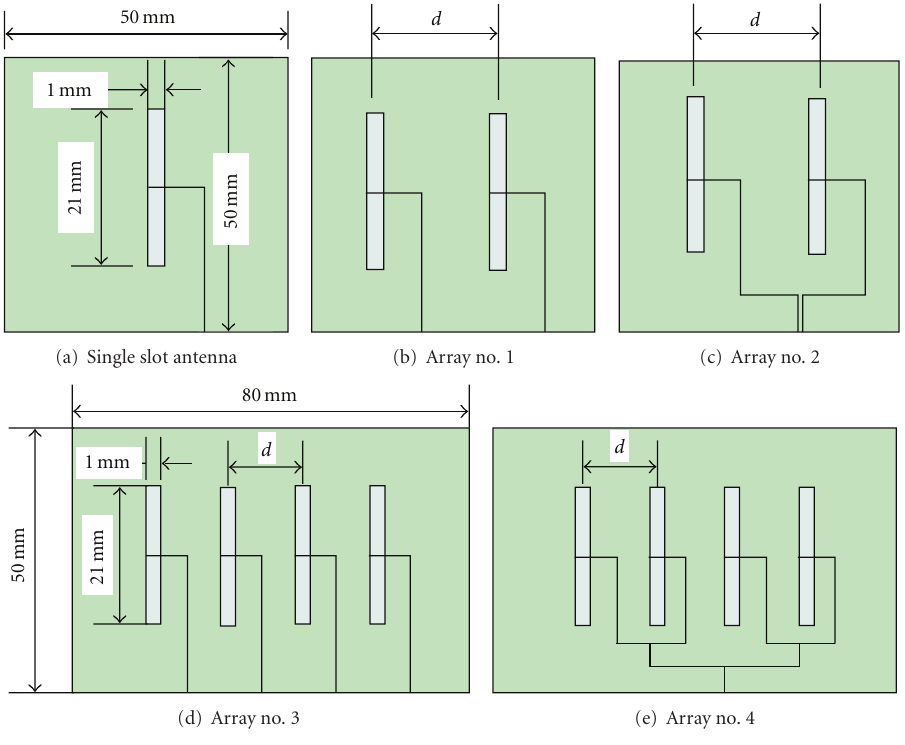
Figure 3: The layout of slot